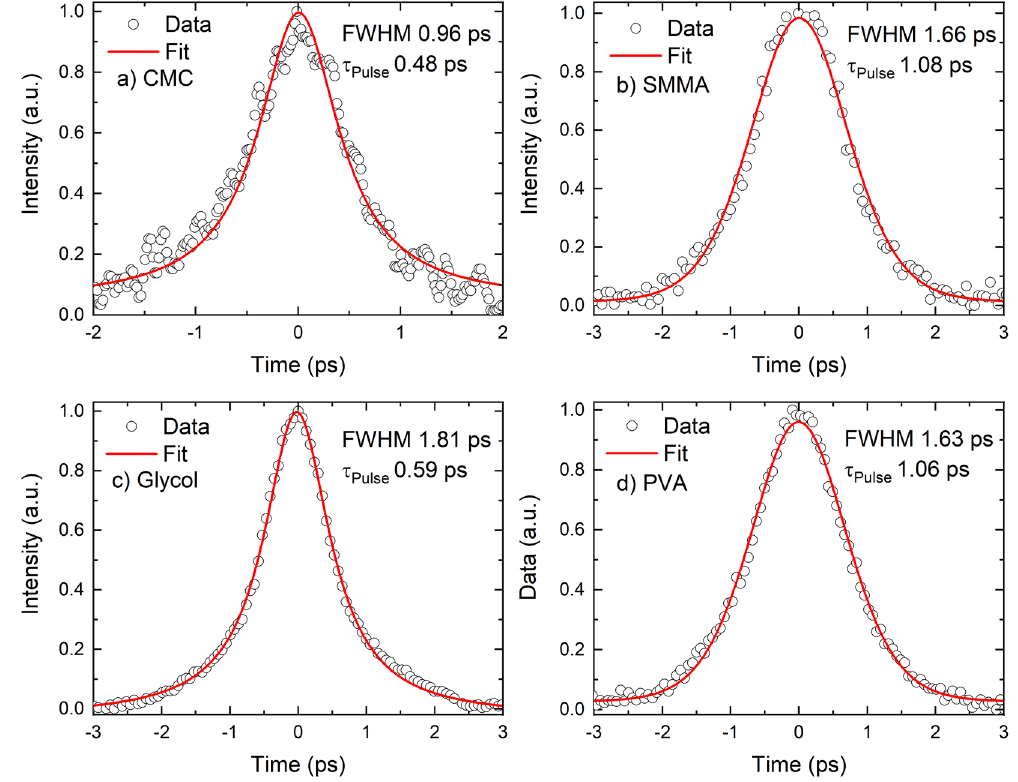
Figure 2. Autocorrelation traces obtained from the mode-locked laser ( a ) CMC, ( b ) SMMA, (c) Glycol and ( d )